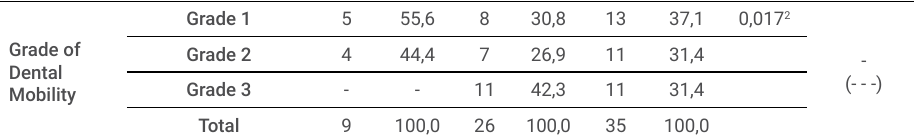
Table 6. Multivariate analysis of the association between independent variables and impact on OHRQoL Variable Coef. E.P. χ 2 Valor p OR 1